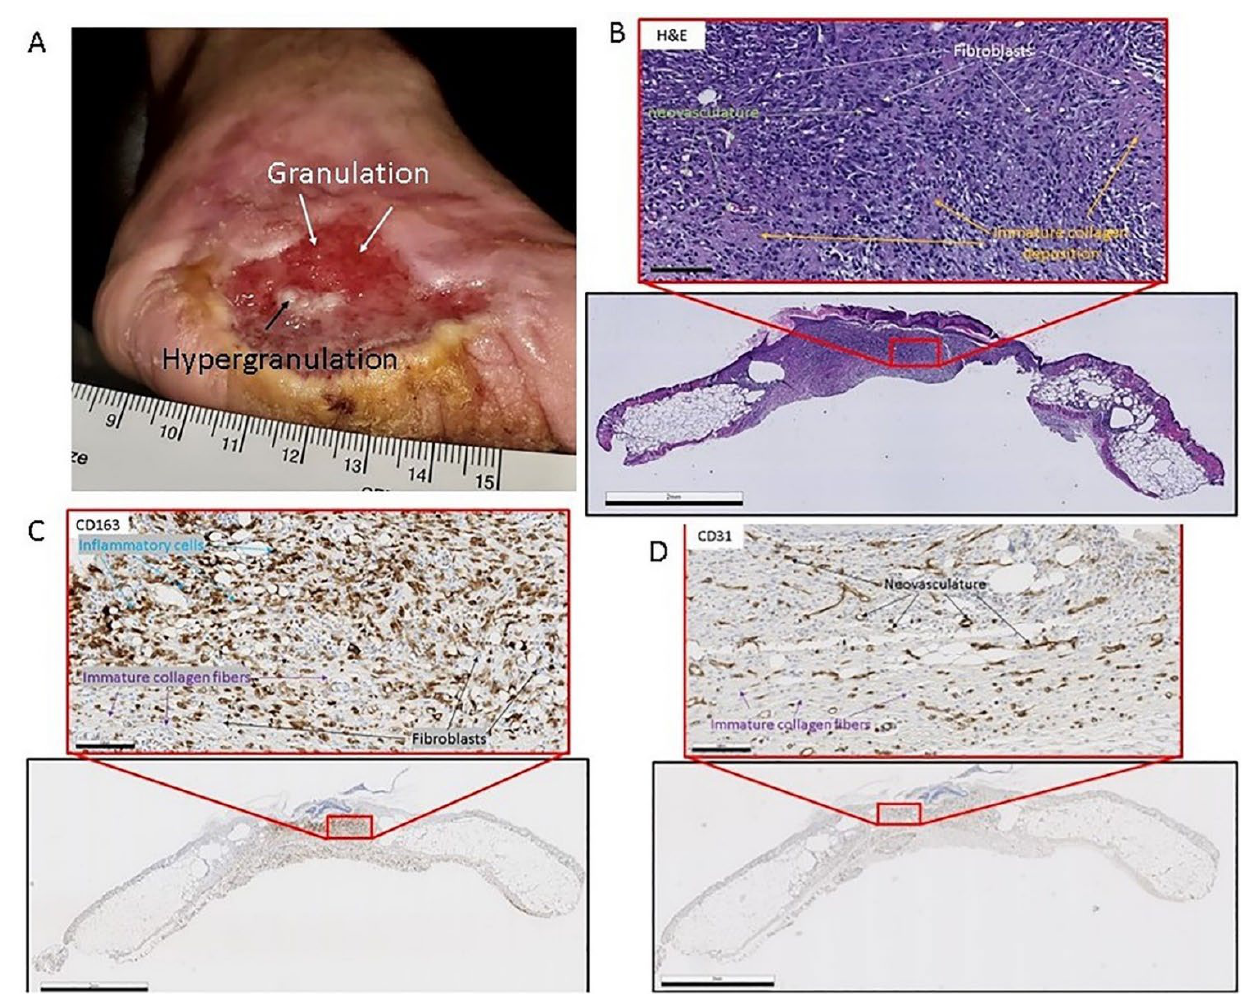
Figure 2. ( A ) Clinical image of chronic diabetic injury with granulation tissue presence. The wound is on the medial aspect of the foot. Notice the white arrow pointing to red tissue indicating cellular infiltrate and neovascularization. The black arrow is pointing to the area in the middle of the wound which is indicative of hyper-granulation. (Patient consent provided). ( B ) Heamatoxalin and Eosin- stained murine skin the black frame is a gross image (scale bar = 2 mm) of the skin sample, and the red framed image (scale bar = 100 µm) is a magnified image of the area in the small red box. The white arrows point to fibroblasts in the granulation tissue. The orange arrows point to immature collagen deposition. The green arrows point to neovasculature. ( C ) CD-163 (Inflammatory cell marker) reacted immunohistochemistry-stained murine skin the black frame is a gross image (scale bar = 2 mm) of the skin sample and the red framed image (scale bar = 100 µm) is a magnified image of the area in the small red box. The black arrows point to fibroblasts in the granulation tissue. The purple arrows point to immature collagen deposition. The blue arrows point to inflammatory cells: macrophages, and monocytes. ( D ) CD-31 (endothelial cell marker) reacted immunohistochemistry- stained murine skin, the black frame is a gross image (scale bar = 2 mm) of the skin sample, and the red framed image (scale bar = 100 µm) is a magnified image of the area in the small red box. The black arrows point to neovasculature in the granulation tissue. The purple arrows point to immature collagen deposition. During proliferation, granulation tissue converts from a cell-rich, highly vascular medium to relatively avascular and acellular matrix of collagen [119,120]. However, elastin is absent from the formed granulation tissue deposited by resident fibroblasts [17]. Elastin has only been demonstrated to be present after these wound stages have progressed,